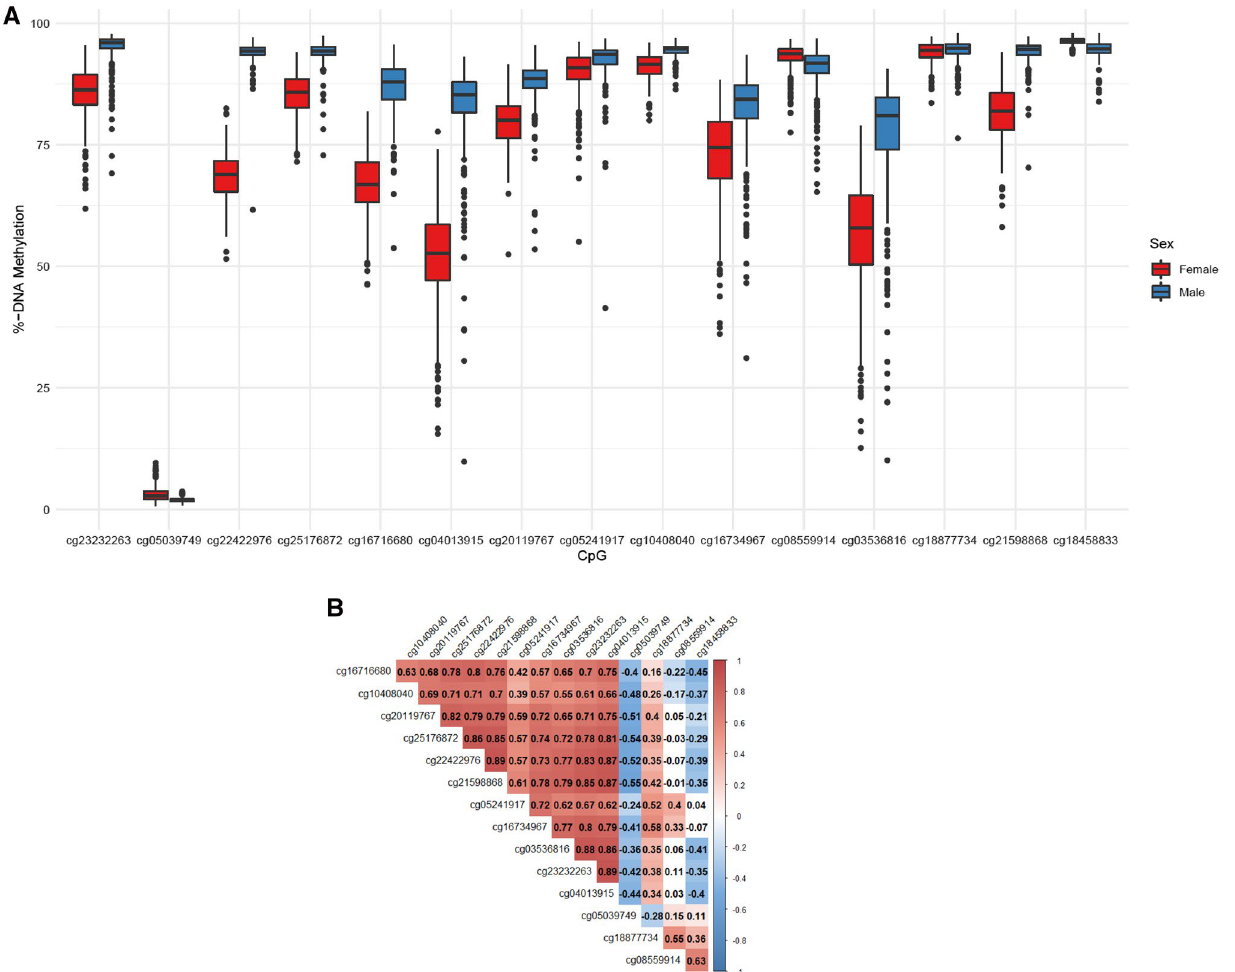
Figure 1. ( A ) Boxplots of DNA methylation in nasal cells for the angiotensin-converting enzyme 2 ( ACE2 ) gene by sex among 15 CpG sites. ( B ) Spearman correlation coefficients of nasal cell DNA methylation levels among CpGs found in the angiotensin-converting enzyme ( ACE2 ) gene. ( C ) Local Manhattan plot for the association of ACE2 DNA methylation for Hispanic relative to white females. Spearman correlation matrix for CpGs among all females. ( D ) Local Manhattan plot for the association of ACE2 DNA methylation for Black relative to white males. Spearman correlation matrix for CpGs among all